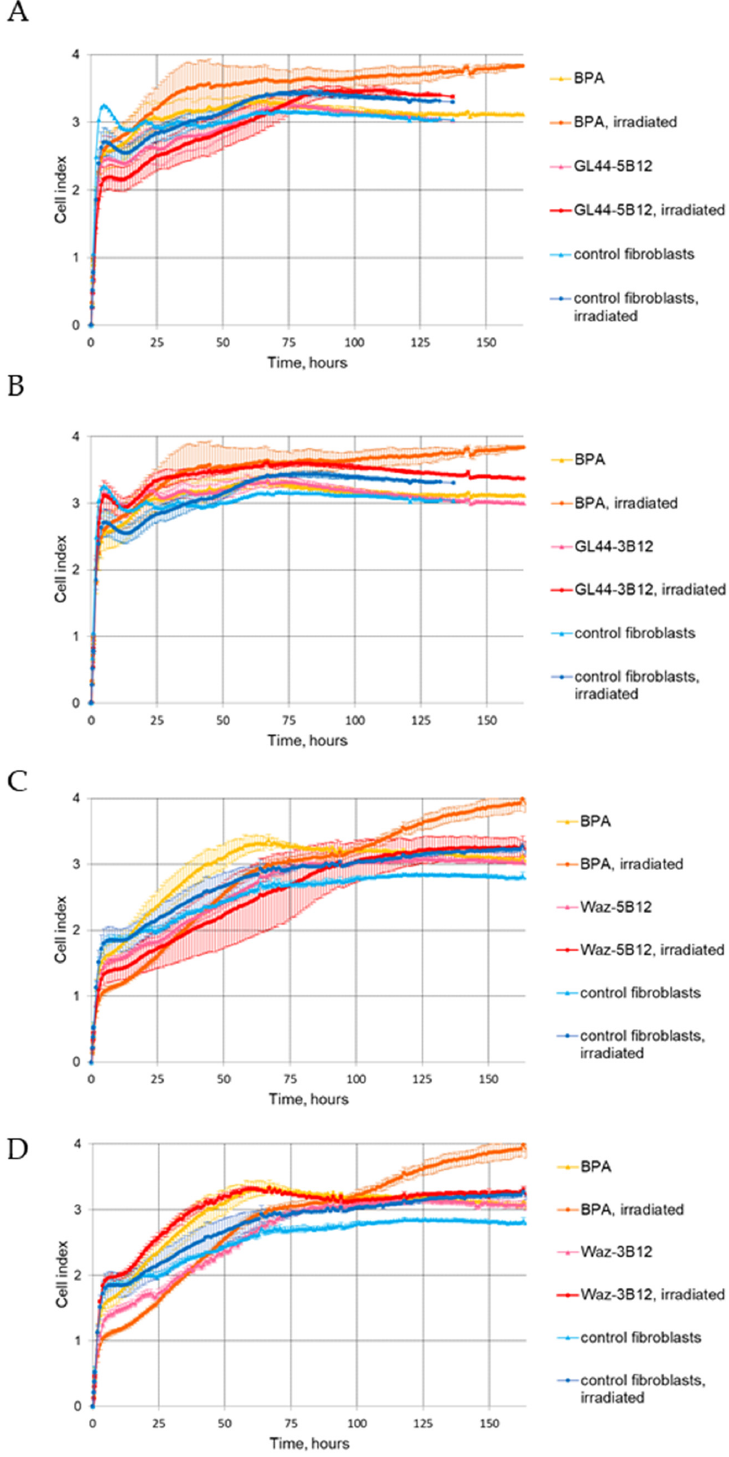
Figure 3. Dynamic RTCA monitoring of cell adhesion and proliferation of hFF8 human fibroblasts after pre ‐ treatment with boron ‐ containing 2 ′‐ F ‐ RNA conjugates GL44 ‐ 5B12 ( A ), GL44 ‐ 3B12 ( B ), Waz ‐ 5B12 ( C ) or Waz ‐ 3B12 ( D ), with or without subsequent irradiation with epithermal neutrons.